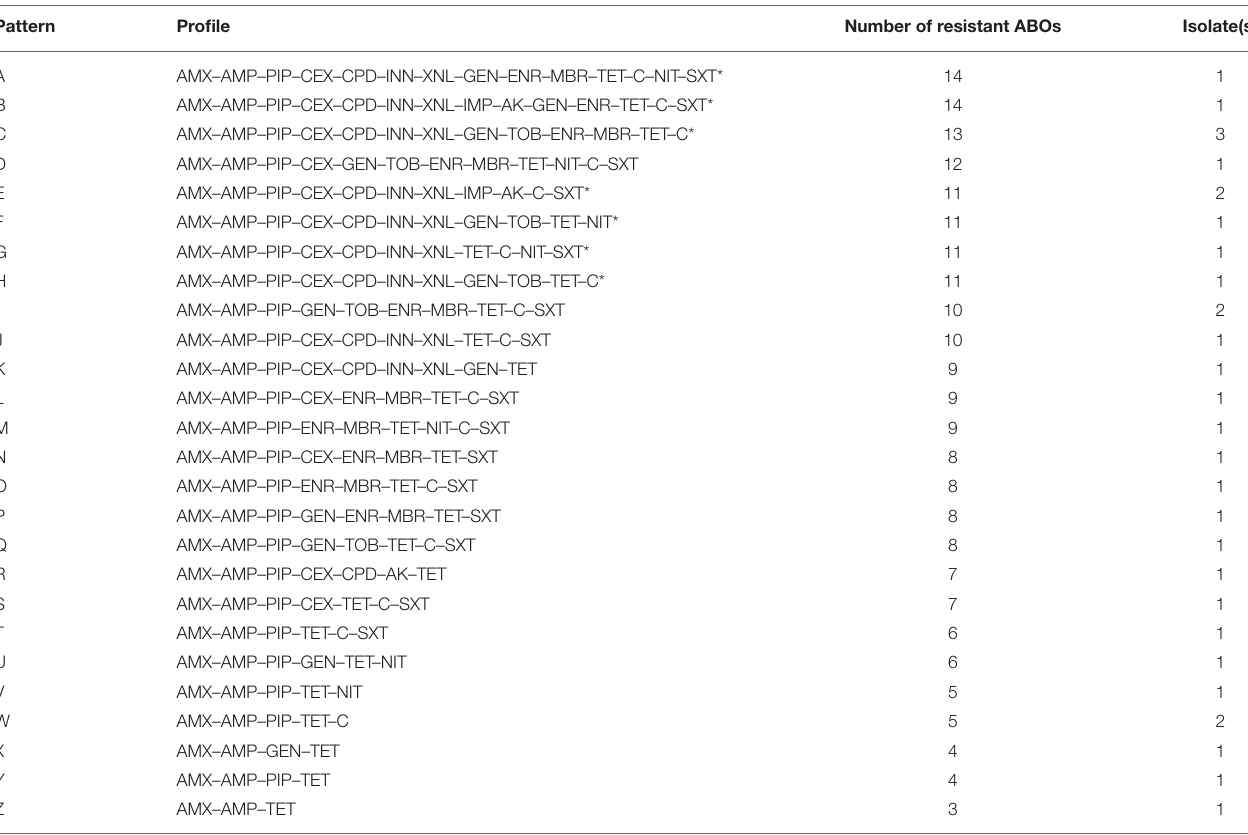
TABLE 1 | Antibiograms of the 31 MCRPE isolates distributing in 26 pattern types.